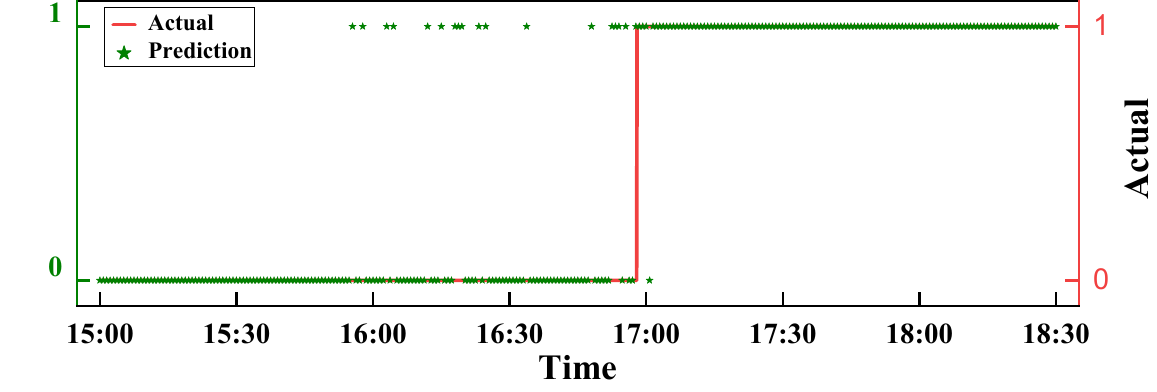
Figure 11. Result of image recognition using SE-ResNet: 1 denotes a positive recognition result (a risk of waterlogging exists) and 0 denotes a negative recognition result (no risk of waterlogging exists).